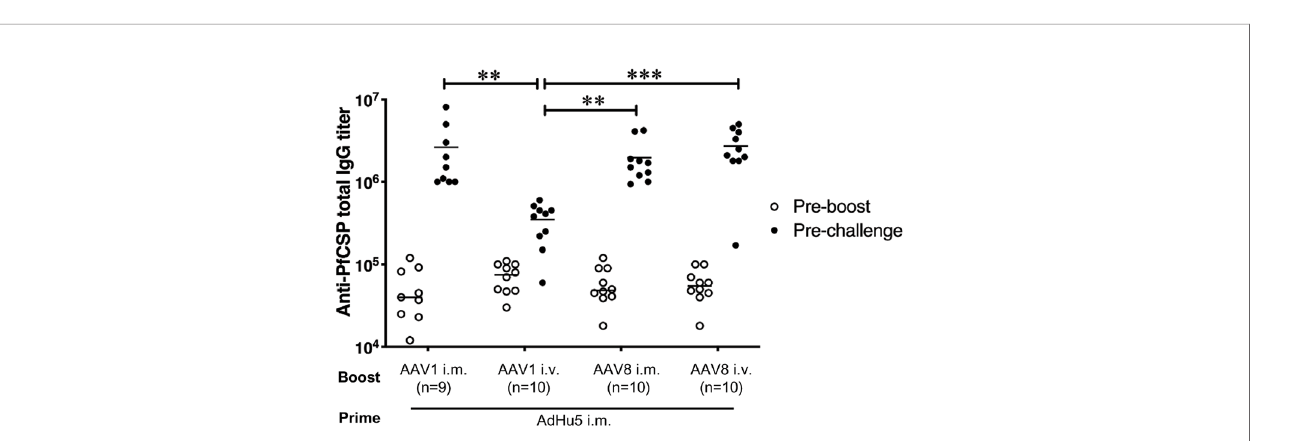
FIGURE 4 | Protective ef fi cacy of AdHu5-PfCSP prime/AAV-PfCSP boost in immunized mice. Mice (n = 9 – 10 per group) were immunized with an AdHu5-PfCSP prime (5 × 10 7 pfu/mouse)/AAV-PfCSP boost (1 × 10 11 vg/mouse) administered with a 6-week interval via the indicated administration routes. Six weeks after receiving booster immunizations, the mice that were challenged with 500 intravenously administered PfCSP-Tc/Pb sporozoites were checked for blood-stage infections by microscopic examination of Giemsa-stained thin smears of tail blood. Protection was de fi ned as the complete absence of blood-stage parasitemia on day 14 post-challenge. The resulting data were statistically analyzed using the Kaplan – Meier log-rank (Mantel – Cox) test. Differences from the PBS group was assessed by a two-way ANOVA. **** p < 0.0001, and * p < 0.05.